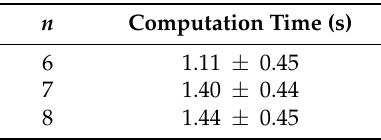
Table 6. Computation time ( n =